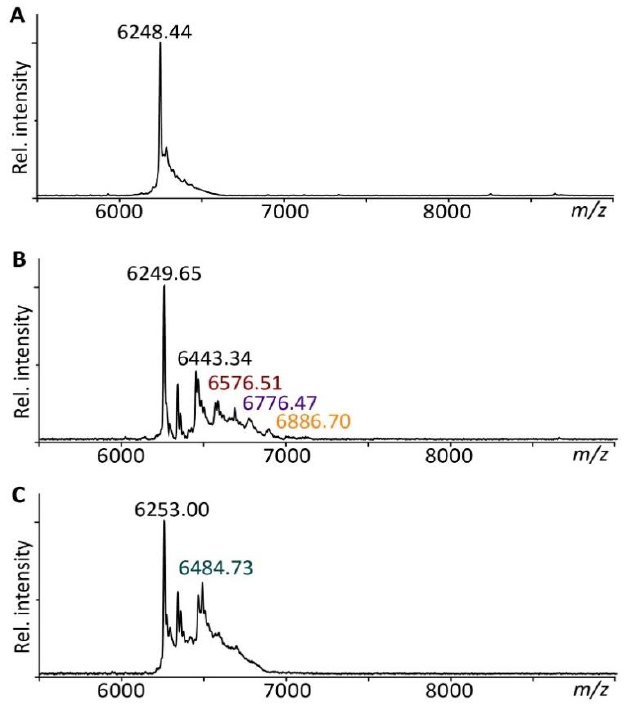
Figure 2. Mass spectra of ( A ) hEGF, ( B ) hEGF and TCO, and ( C ) hEGF–TCO and tetrazine, showing various peaks belonging to free hEGF and EGF with various TCO adducts indicative of successful hEGF – TCO coupling.